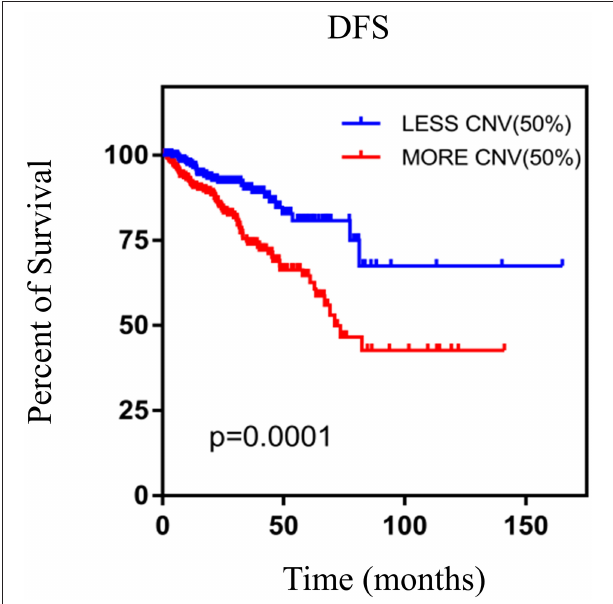
FIGURE 5 | The Kaplan–Meier survival analysis of nine genes. p < 0.05 was considered statistically different. DFS, disease-free survival; CNV, copy number